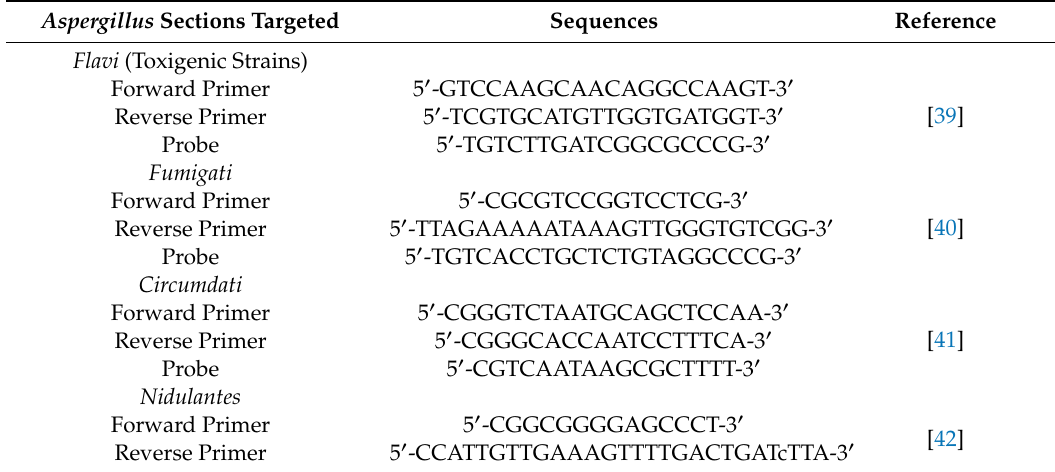
Table 2. Sequence of primers and TaqMan probes used for Real Time